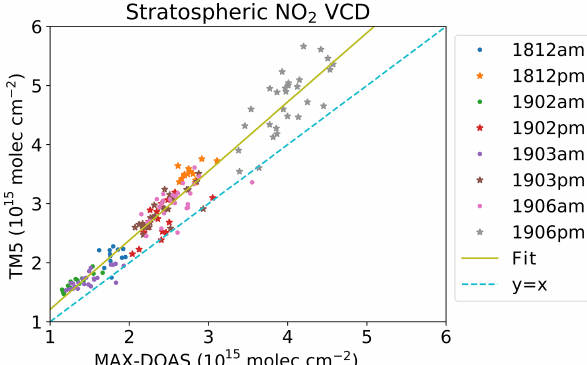
Figure 5. Scatter plot of TM5 stratospheric NO 2 vertical col- umn densities versus MAX-DOAS stratospheric NO 2 vertical col- umn densities. The abbreviations “am” and “pm” represent MAX- DOAS NO 2 vertical column density mean values between a solar zenith angle of 75 and 89 ◦ in the morning and in the evening, re- spectively. The numbers 1812, 1902, 1903, and 1906 refer to the years (2018, 2019) and months (December, February, March, June) of the cruises. The correlation coefficient is R = 0 . 97. The fit is y = 1 . 17 x + 3 . 86 × 10 13 molec cm − 2